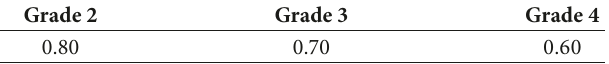
Table 5: Reference list of accuracy test grade.